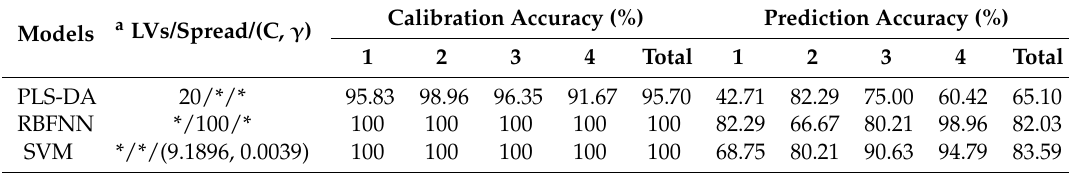
Table 1. The results of the partial least squares-discriminant analysis (PLS-DA), radial basis function neural network (RBFNN) and support vector machine (SVM) models on the full LIBS data. Models a LVs/Spread/(C, γ